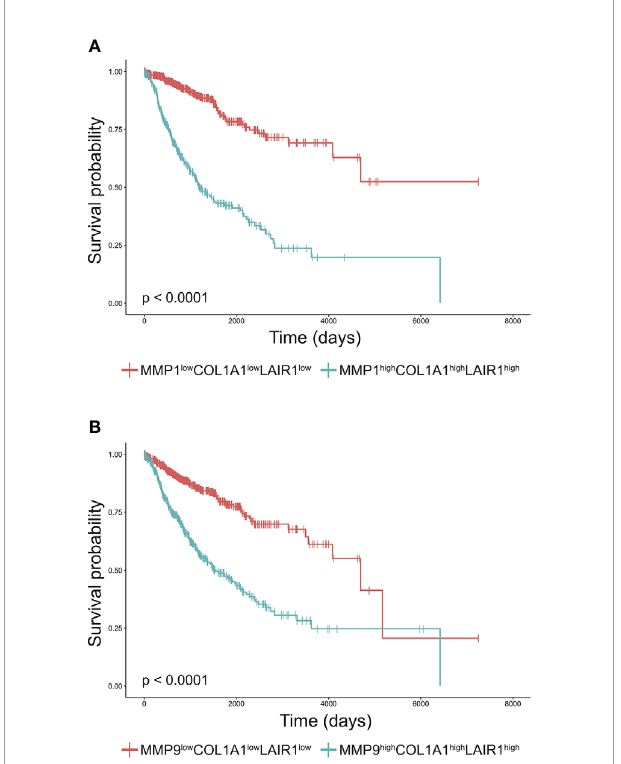
FIGURE 1 | High MMP, collagen I and LAIR1 expression correlate to poor survival of cancer patients. (A, B) Kaplan-Meier plots of the overall-survival probability for the subgroups of patients. (A) Cancer patients from the TCGA database were strati fi ed into MMP1 high COL1A1 high LAIR1 high and MMP1 low COL1A1 low LAIR1 low based on the top 25% and bottom 25% tumoral mRNA expression respectively. Similarly, patients were strati fi ed into (B) MMP9 high COL1A1 high LAIR1 high and MMP9 low COL1A1 low LAIR1 low . Signi fi cant differences in Kaplan-Meier plots were evaluated using a logrank test and are indicated in the bottom left corner of each graph (all p <